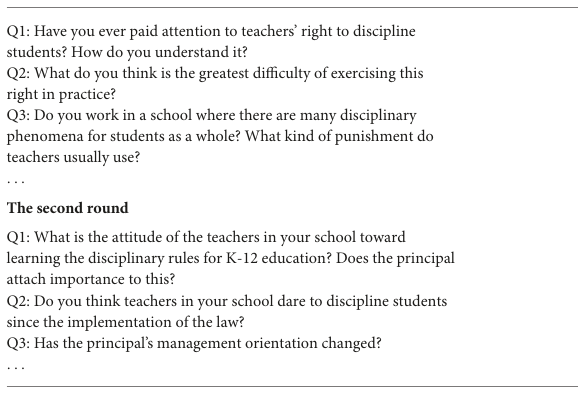
TABLE 2 Profiles of the participant